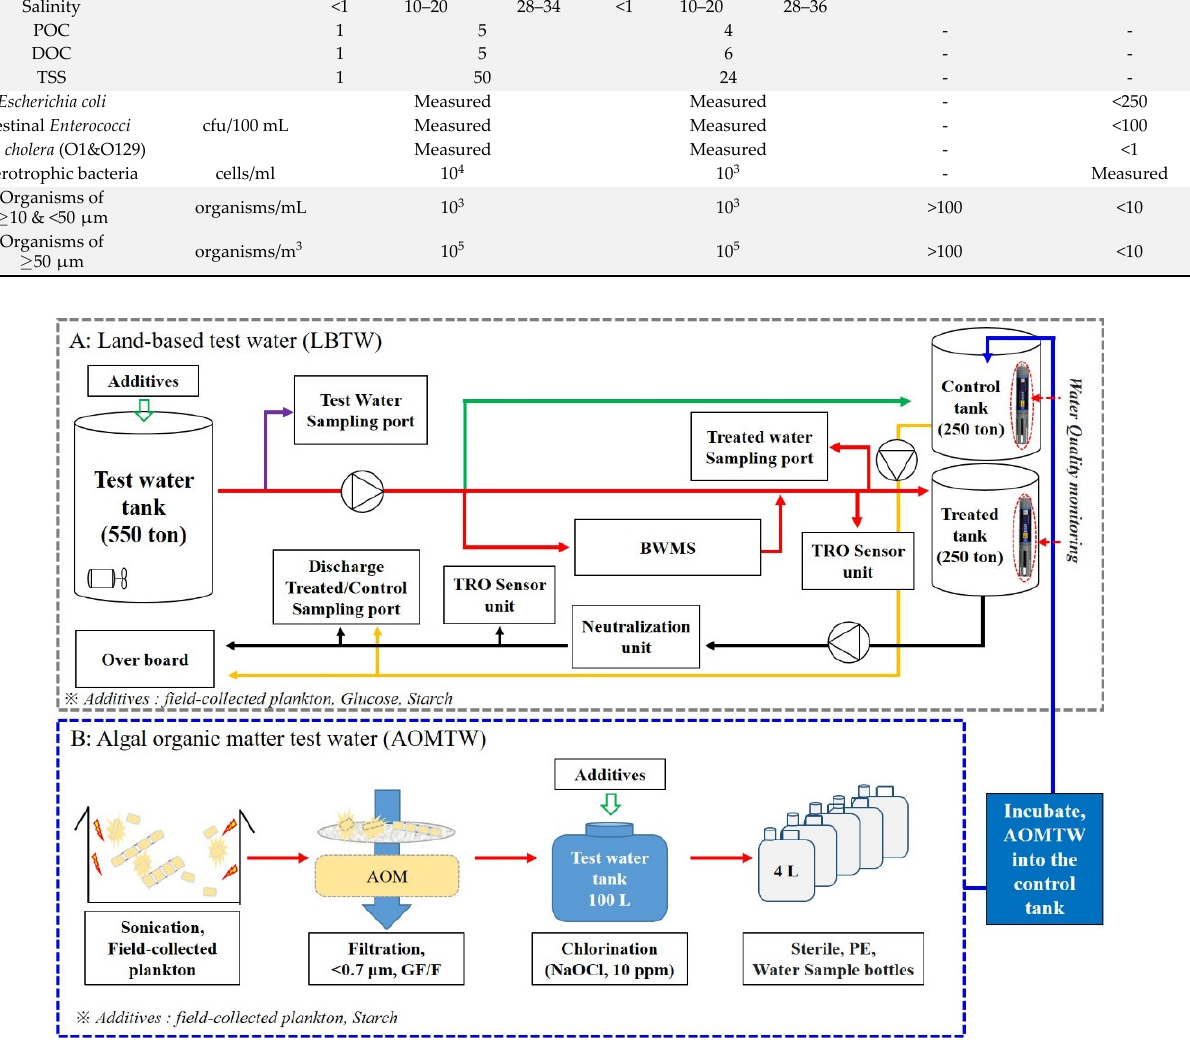
Figure 1 . A schematic diagram of the test process in ( A ) land-based test water and ( B ) algal organic Figure 1. A schematic diagram of the test process in ( A ) land‑based test water and ( B ) algal organic matter test water. matter test